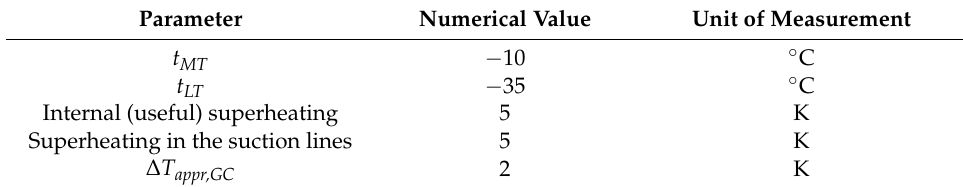
Table 4. Additional assumptions made for the conventional exergy analysis [10,22].